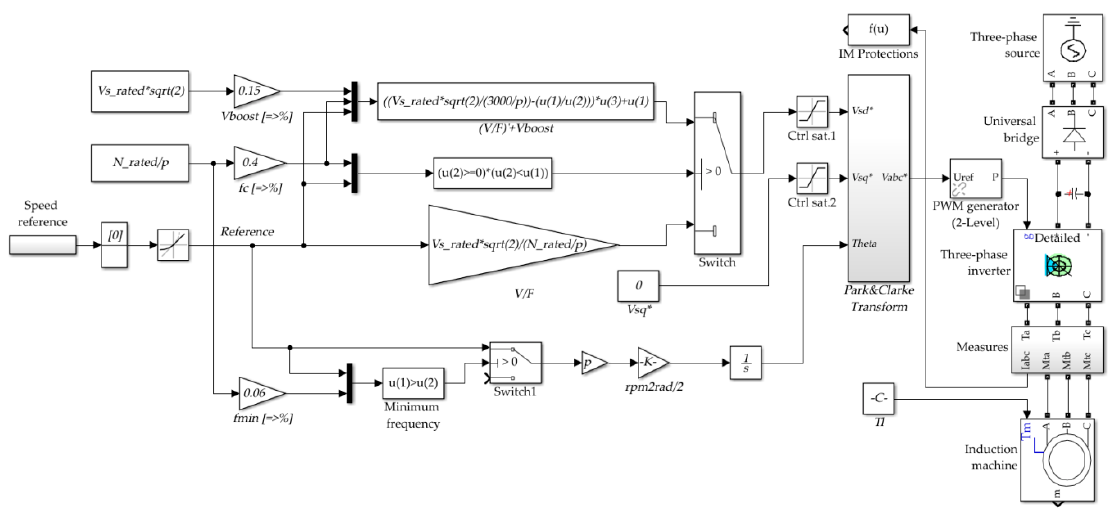
Figure 1. Simulink block diagram of basic SCS for the induction motor (IM).